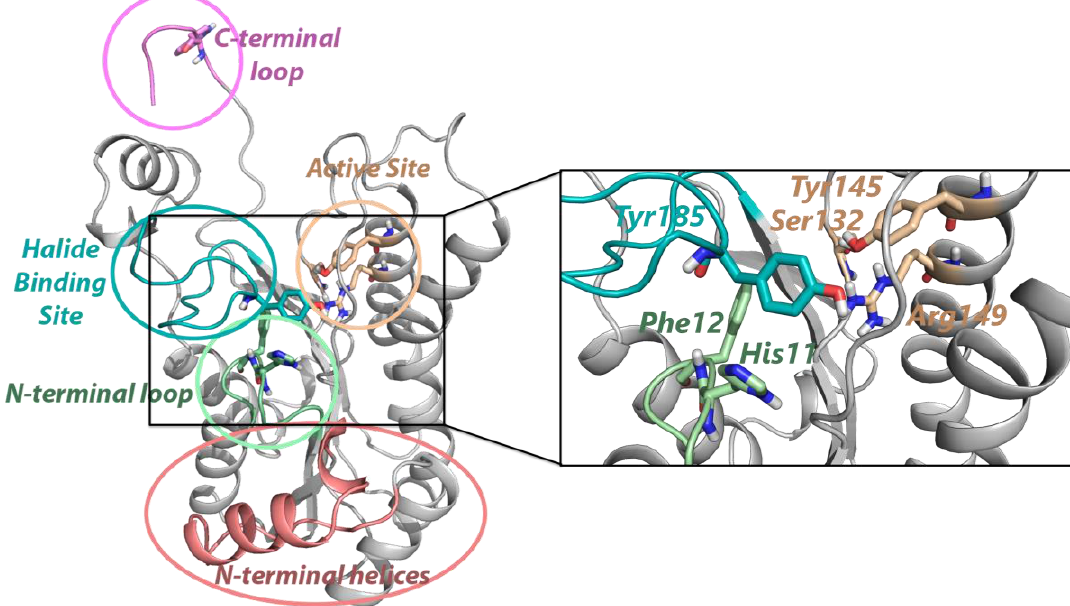
Figure 1. Halohydrin dehalogenase (HHDH) distinct structural elements and zoom of the active site and halide binding pockets based on the HheC structure. Active site residues are highlighted in wheat color, halide-binding site in teal, N-terminal loop in light green, C-terminal loop in purple and N-terminal 6–7 helices in salmon. In the active site zoom, potential residues blocking the accessible active site tunnels are depicted using the same color